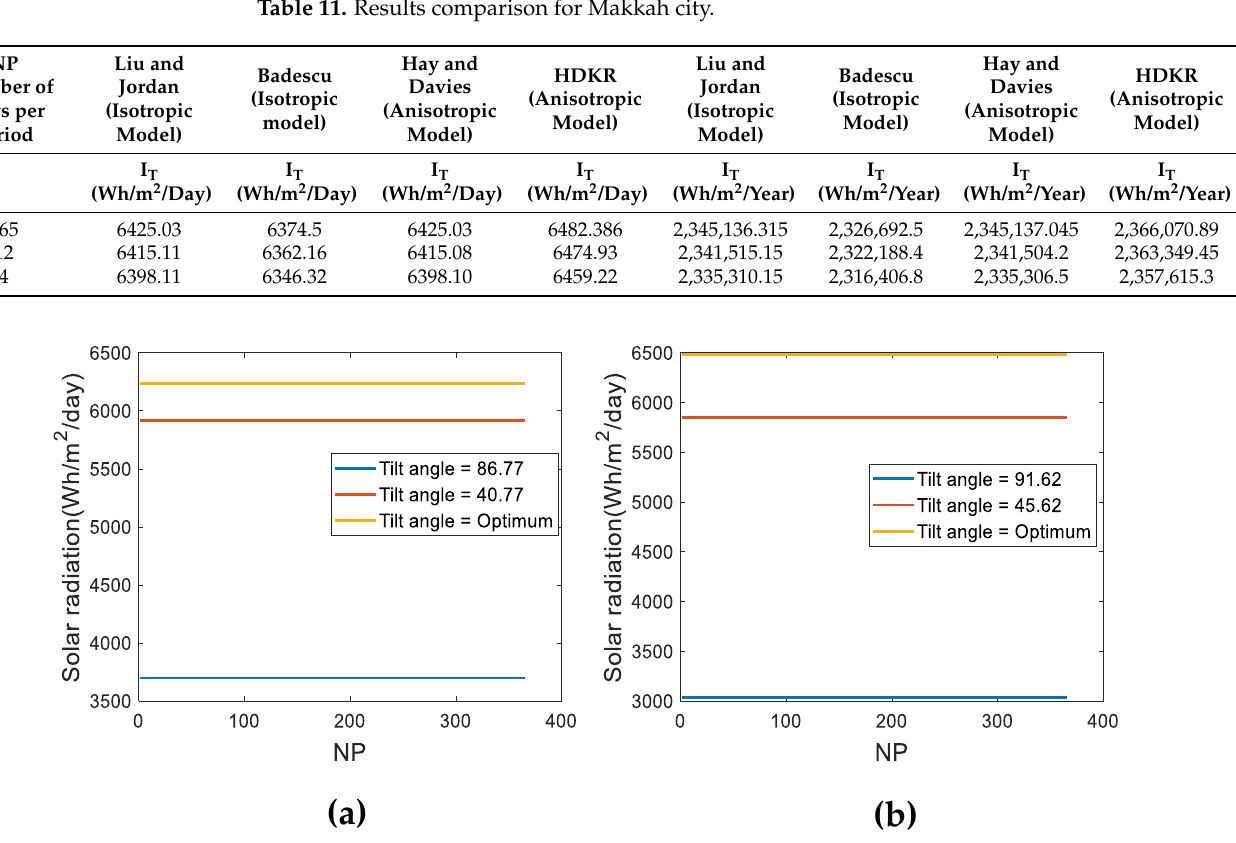
Figure 11. Optimum and adjusted tilt angle comparison of solar radiation: ( a ) Dhahran city, ( b ) Makkah city.